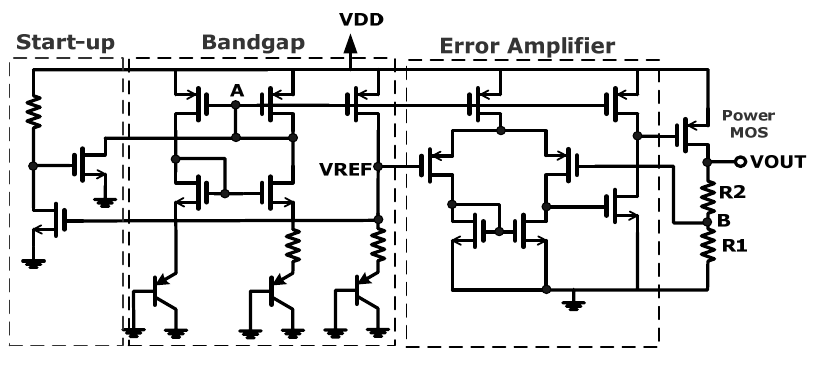
Figure 11. Schematic of the